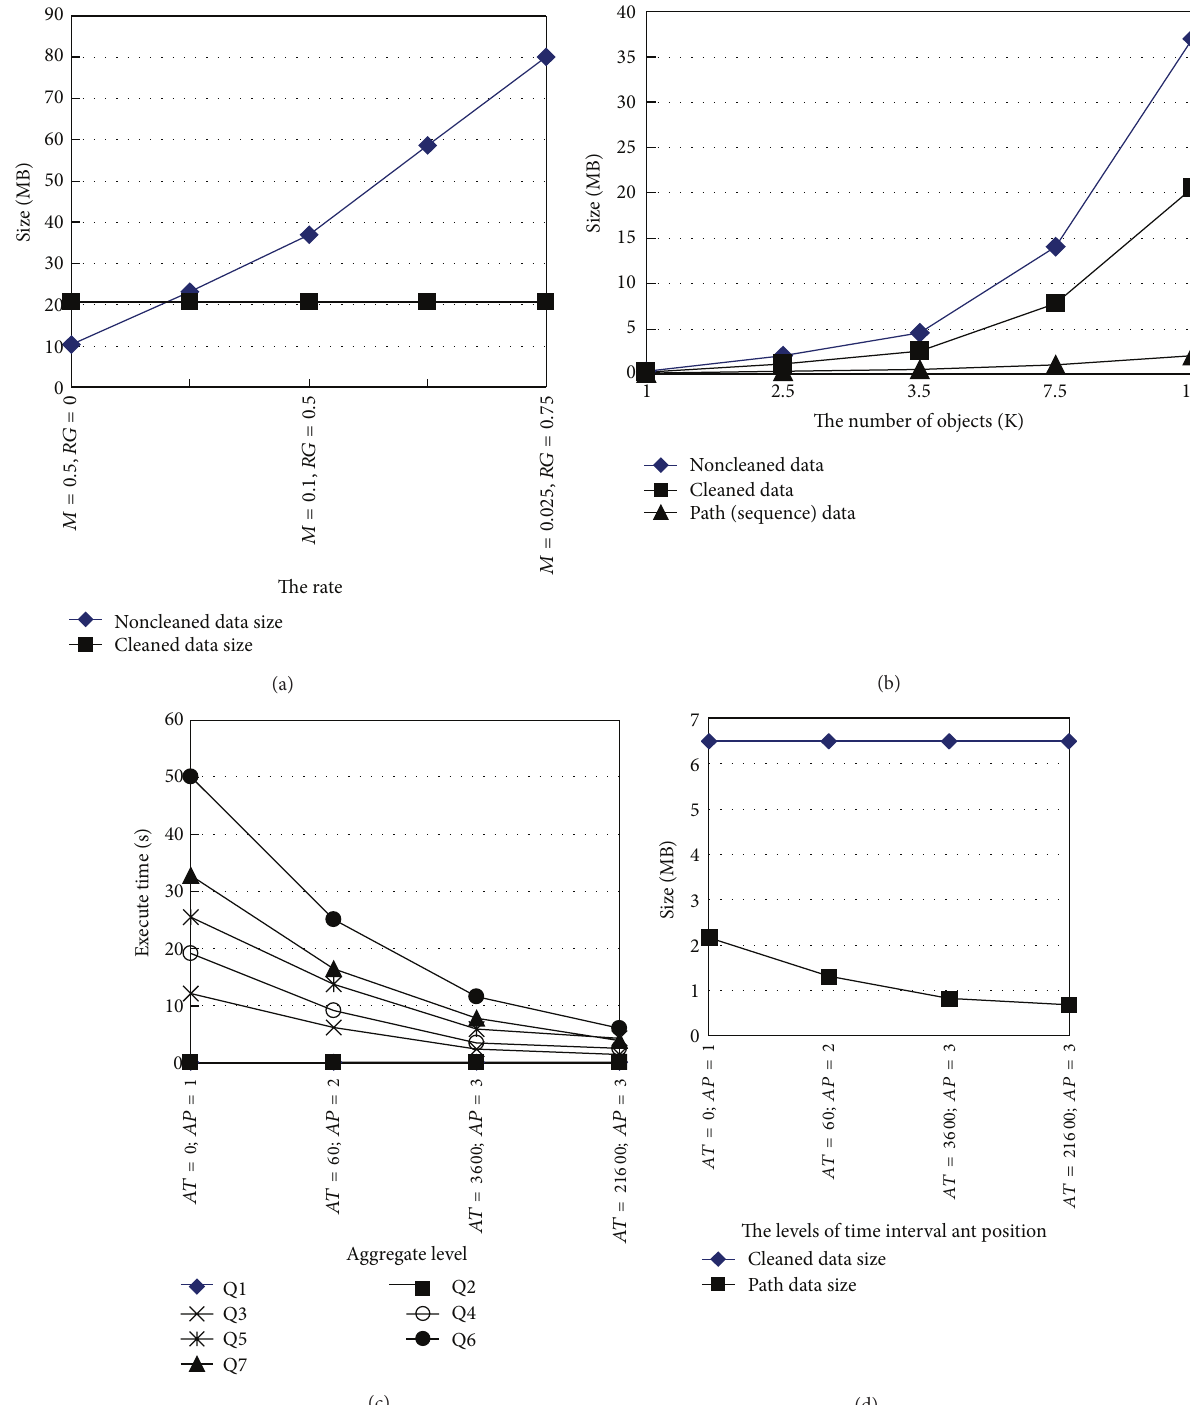
Figure 10: (a) Different rates of missing, redundant, and ghost data. (b) Different data sizes. (c) Different path lengths. (d) Different aggregate levels of positions and time